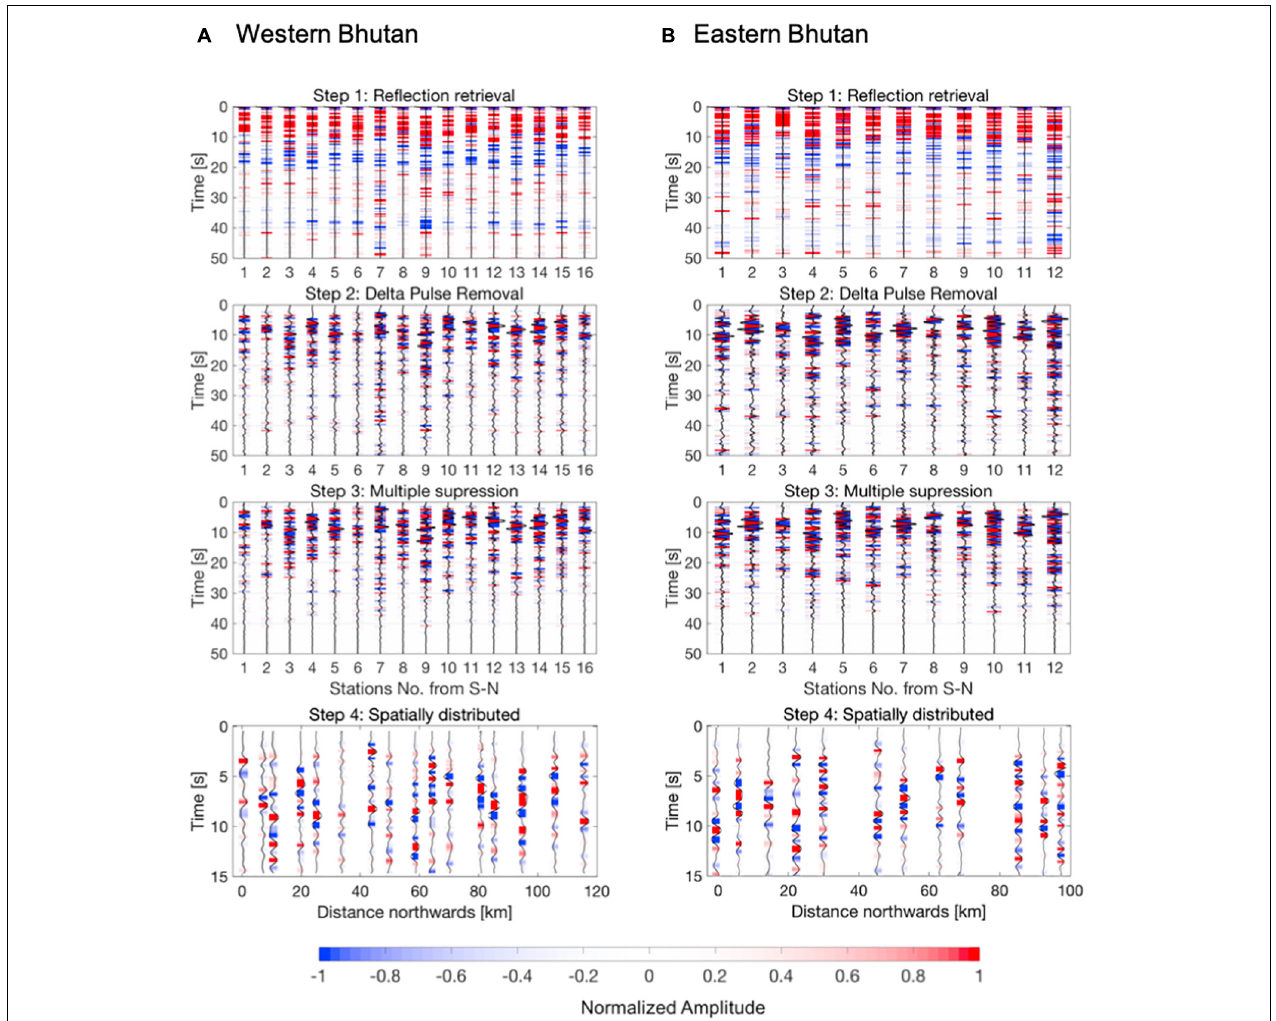
FIGURE 3 | Data processing steps for the profiles in Western (A) and Eastern (B) Bhutan. After autocorrelation and stacking (step 1), the delta pulse is removed (step 2), and the multiples are suppressed (step 3). In step 4, the traces are shown with accurate spatial distribution for the first 15 s, which correspond to a depth of around 100 km. The amplitudes are normalized to the maximum value after each processing step, which causes the shift in colors after the delta pulse